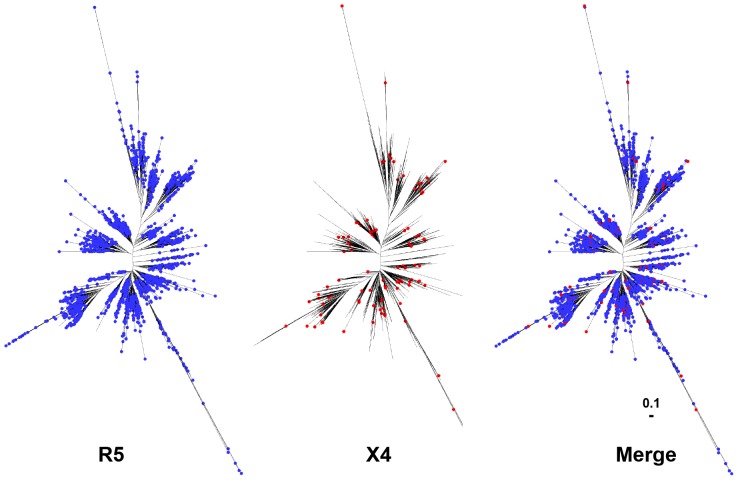
Comparative analysis of full-length X4 and R5 HIV-1 gp120 phylogenetic trees.A total of 11,010 full-length gp120s derived from LANL and the co-receptor usage was analyzed using the PSSM algorithm, giving 10,477 of R5 (blue circles) and 533 of X4 sequences (red circles). The phylogenetic tree is subsequently constructed using the maximum-likelihood method.